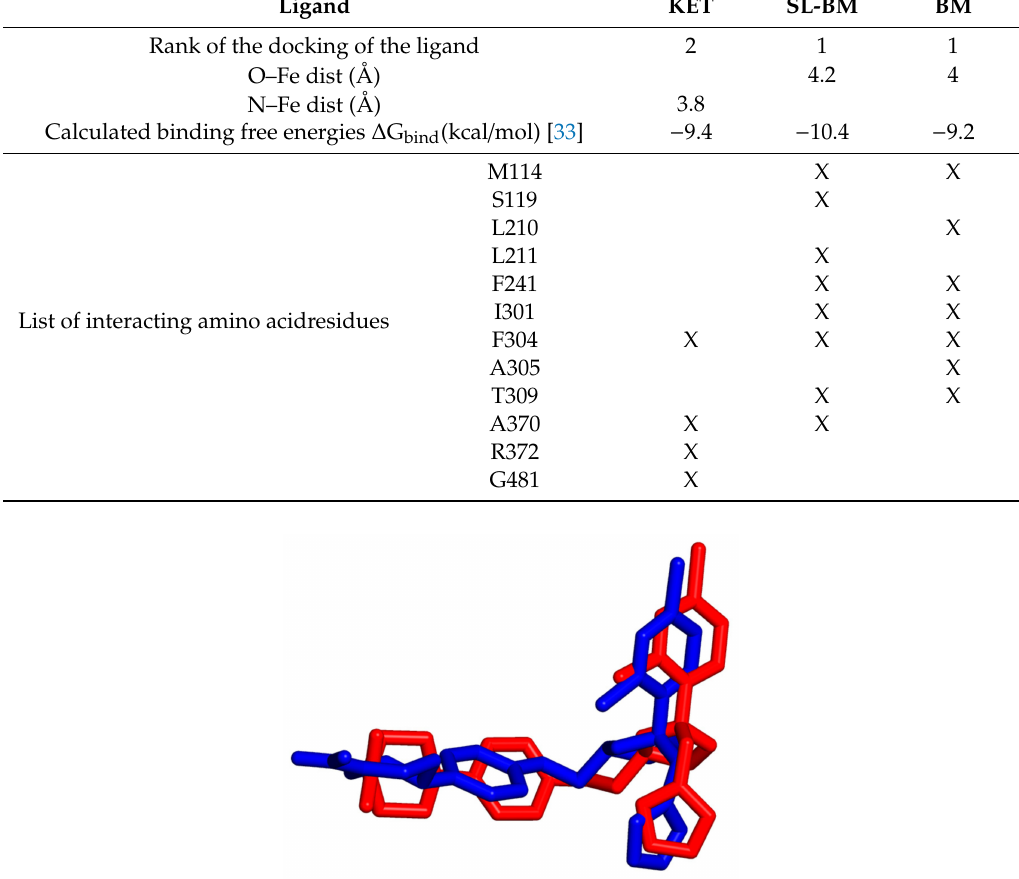
Figure 3. The docked (red) binding mode of KET overlaps with its crystallographic binding mode (blue), which is located above the heme ring (not shown).